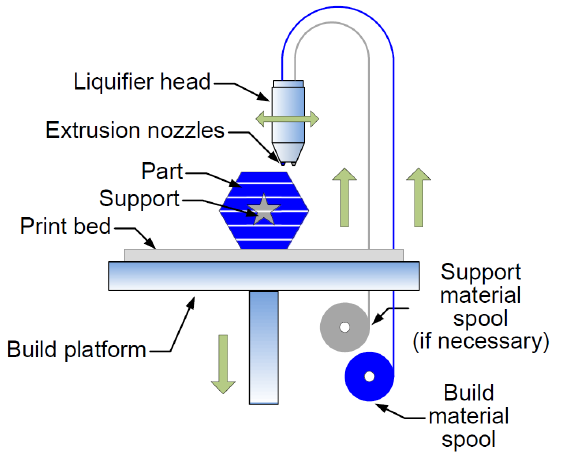
Figure 6. Example of FDM printer printing. (Reprinted from Composites Part B: Engineering , Volume 80, Fuda Ning, Weilong Cong, Jingjing Qiu, Junhua Wei, Shiren Wang, Additive manufacturing of